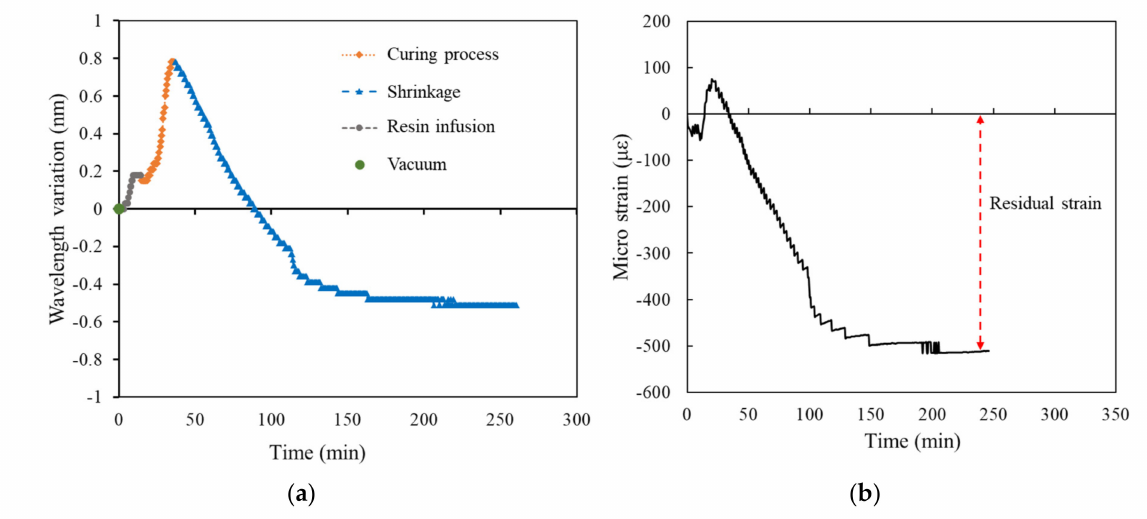
Figure 11. Experimental results of surface laminate-stacking number is 20. ( a ) Wavelength-variation varying with time. ( b ) Residual